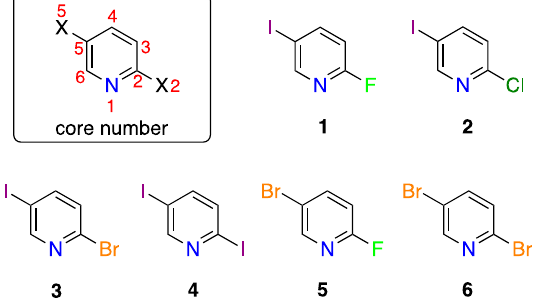
Figure 1. Chemical structures of 2,5-dihalopyridines: 2-fluoro-5-iodopyridine ( 1 ), 2-chloro-5- iodopyridine ( 2 ), 2-bromo-5-iodopyridine ( 3 ), 2,5-diiodopyridine ( 4 ), 2-fluoro-5-bromopyridine ( 5 ), and 2,5-dibromopyridine ( 6 ).